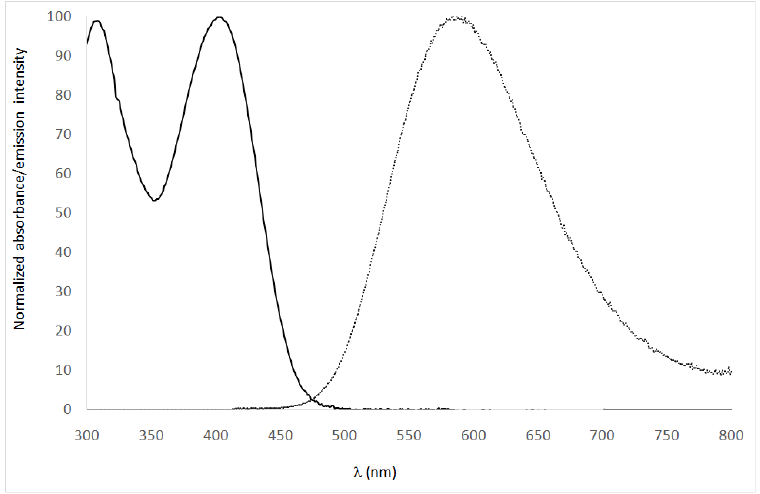
Figure 1. Normalized absorption and emission spectra of 1 in DCM.